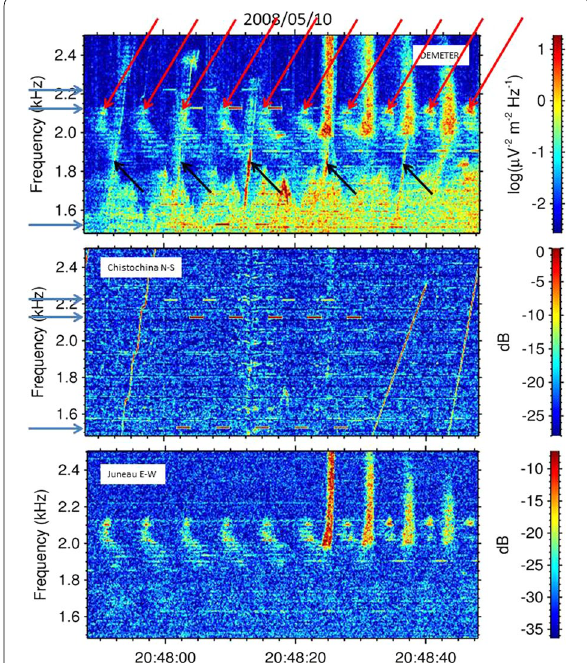
Fig. 23 Zoom of Fig. 21 showing data between 20:47:48 and 20:48:48 UT in the frequency range 1.5–2.5 kHz. The power spectral density is color-coded according to the scale on the right